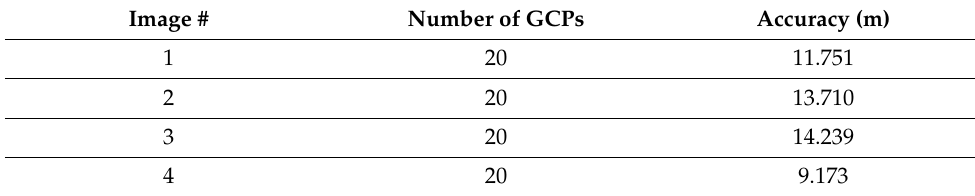
Table 5. Accuracy of georeferencing by image.